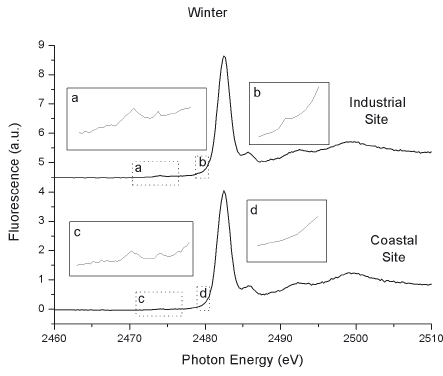
Figure 2. Sulphur K-edge XANES spectra for the PM10 samples of the two sites collected during the winter season (zoomed areas a and c: detail between 2470 eV and 2478 eV; zoomed areas b and d: detail between 2478 eV and 2480 eV).